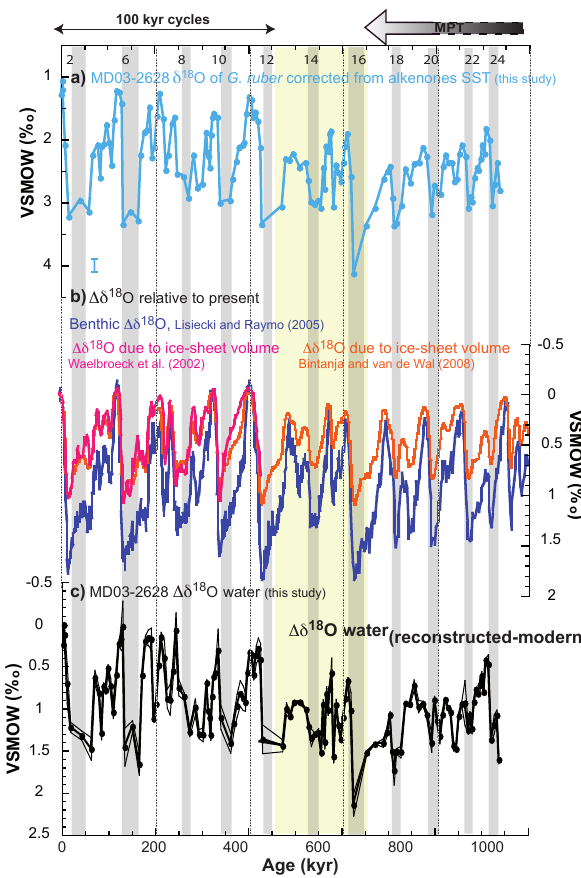
Fig. 6 Fig. 6. The calculation steps for the correction procedure for MD03- 2628 δ 18 O for Globigerinoides ruber . (a) The core MD03-2628 δ 18 O record (blue curve and dots) corrected for temperature effects 0 using sea-surface temperatures (from the U K index) and the equa- 37 tion of Mulitza et al. (2003). The error bar at the left shows the error in the calculation due to SST uncertainty. (b) The global oceanic 1δ 18 O relative to the present; the global benthic 1δ 18 O stack from Lisiecki and Raymo (2005) is shown in dark blue. From this record, Bintanja and van de Wal (2008) extracted the ice-volume effect (IVE, orange curve) in global 1δ 18 O. The IVE effect was also re- contructed by Waelbroeck et al. (2002) (pink curve). See the text for calculation details. (c) Variations in the δ 18 O of seawater rel- ative to modern values (noticed 1δ 18 O) at the core MD03-2628 location calculated using the records in (a) and (b) . The black bold line is the average of a global IVE correction from Waelbroeck et al. (2002) and Bintanja and van de Wal (2008). The standard devia- tion is indicated by the thin lines and includes the variability of both IVE reconstructions as well as an uncertainty of ± 2.5ka on the core MD03-2628 age model. See the text for calculation details. Light gray bars, even numbers, and yellow area are the same as in Fig.